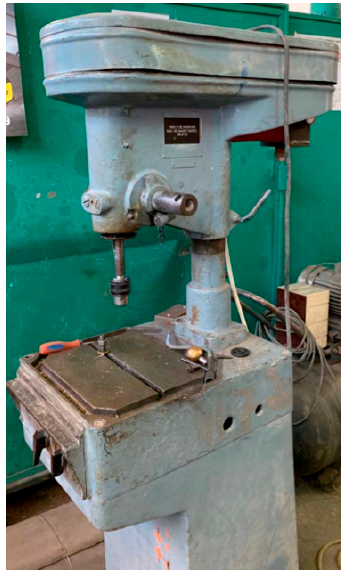
Figure 3. G13 drilling machine used for Friction Riveting.